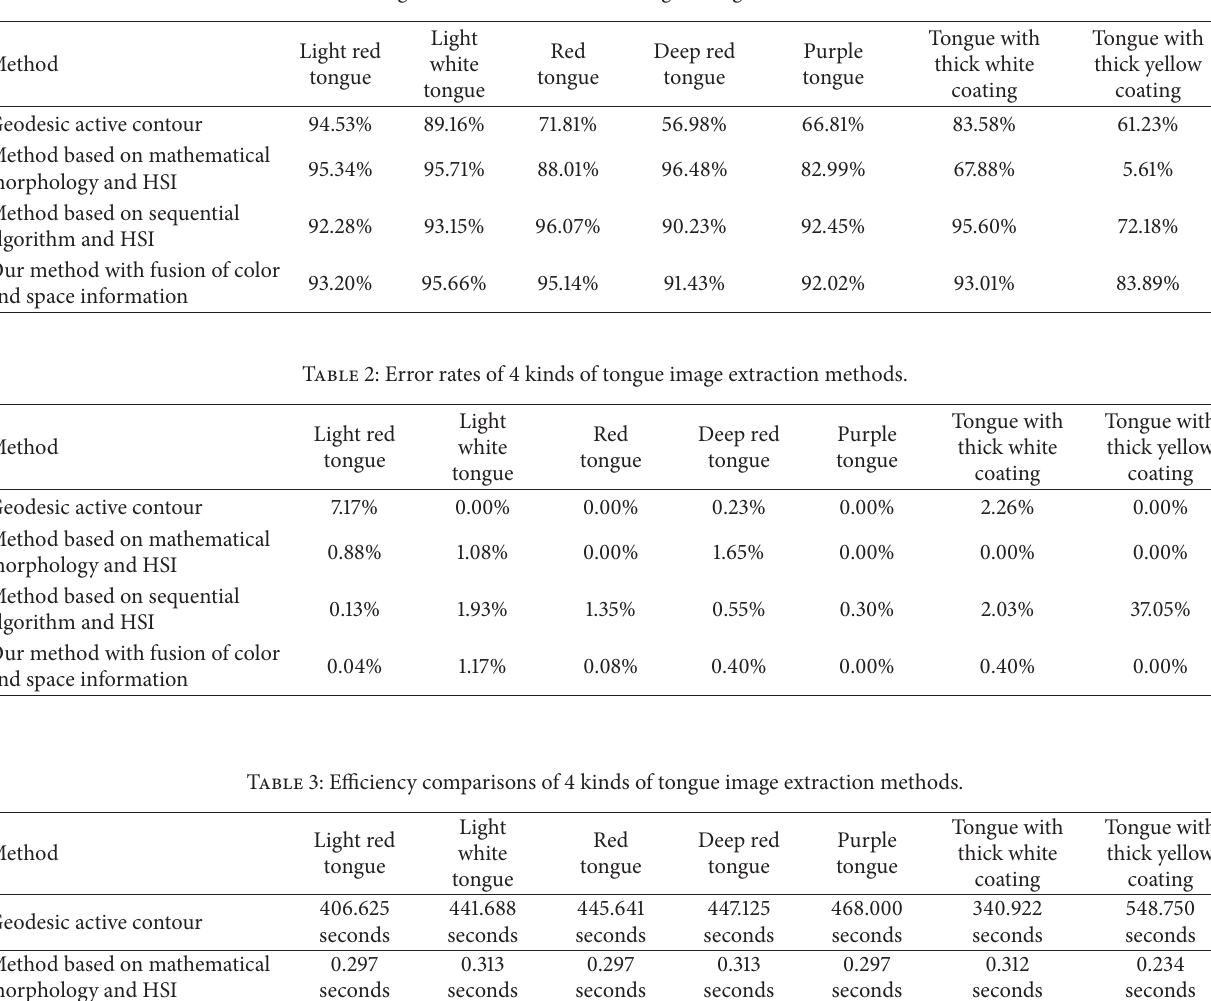
Table 1: Recognition rates of 4 kinds of tongue image extraction methods.